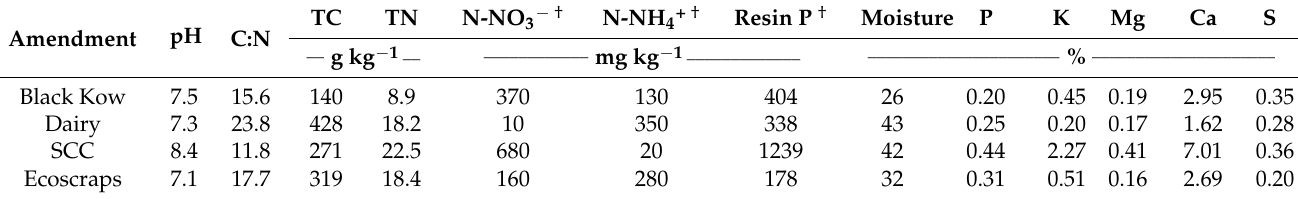
Table 3. Properties of amendments measured at the start of the study. All measurements were conducted on one sample with dry amendments, except for those indicated as fresh amendments ( †